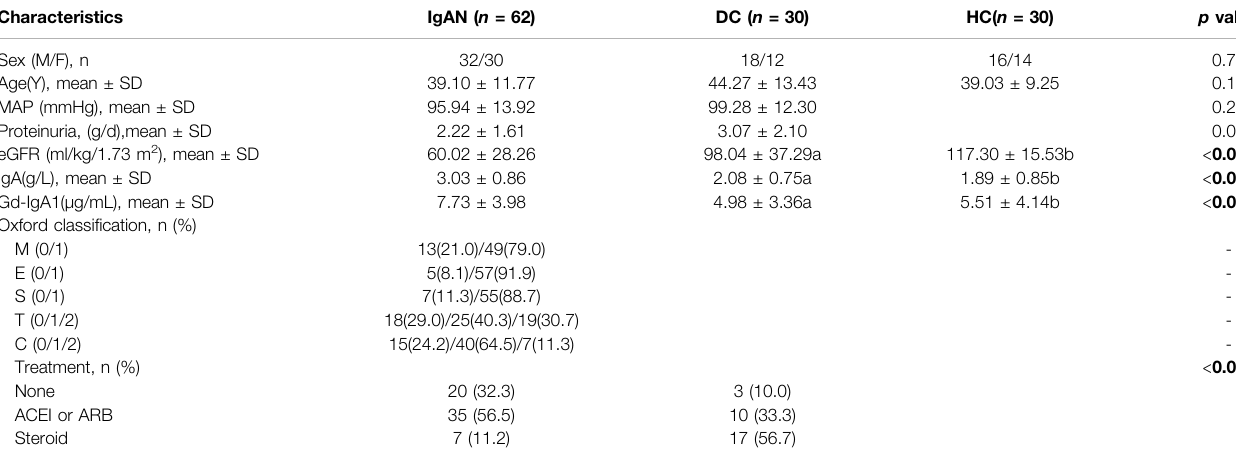
TABLE 1 | Clinicopathological characteristics of participants.